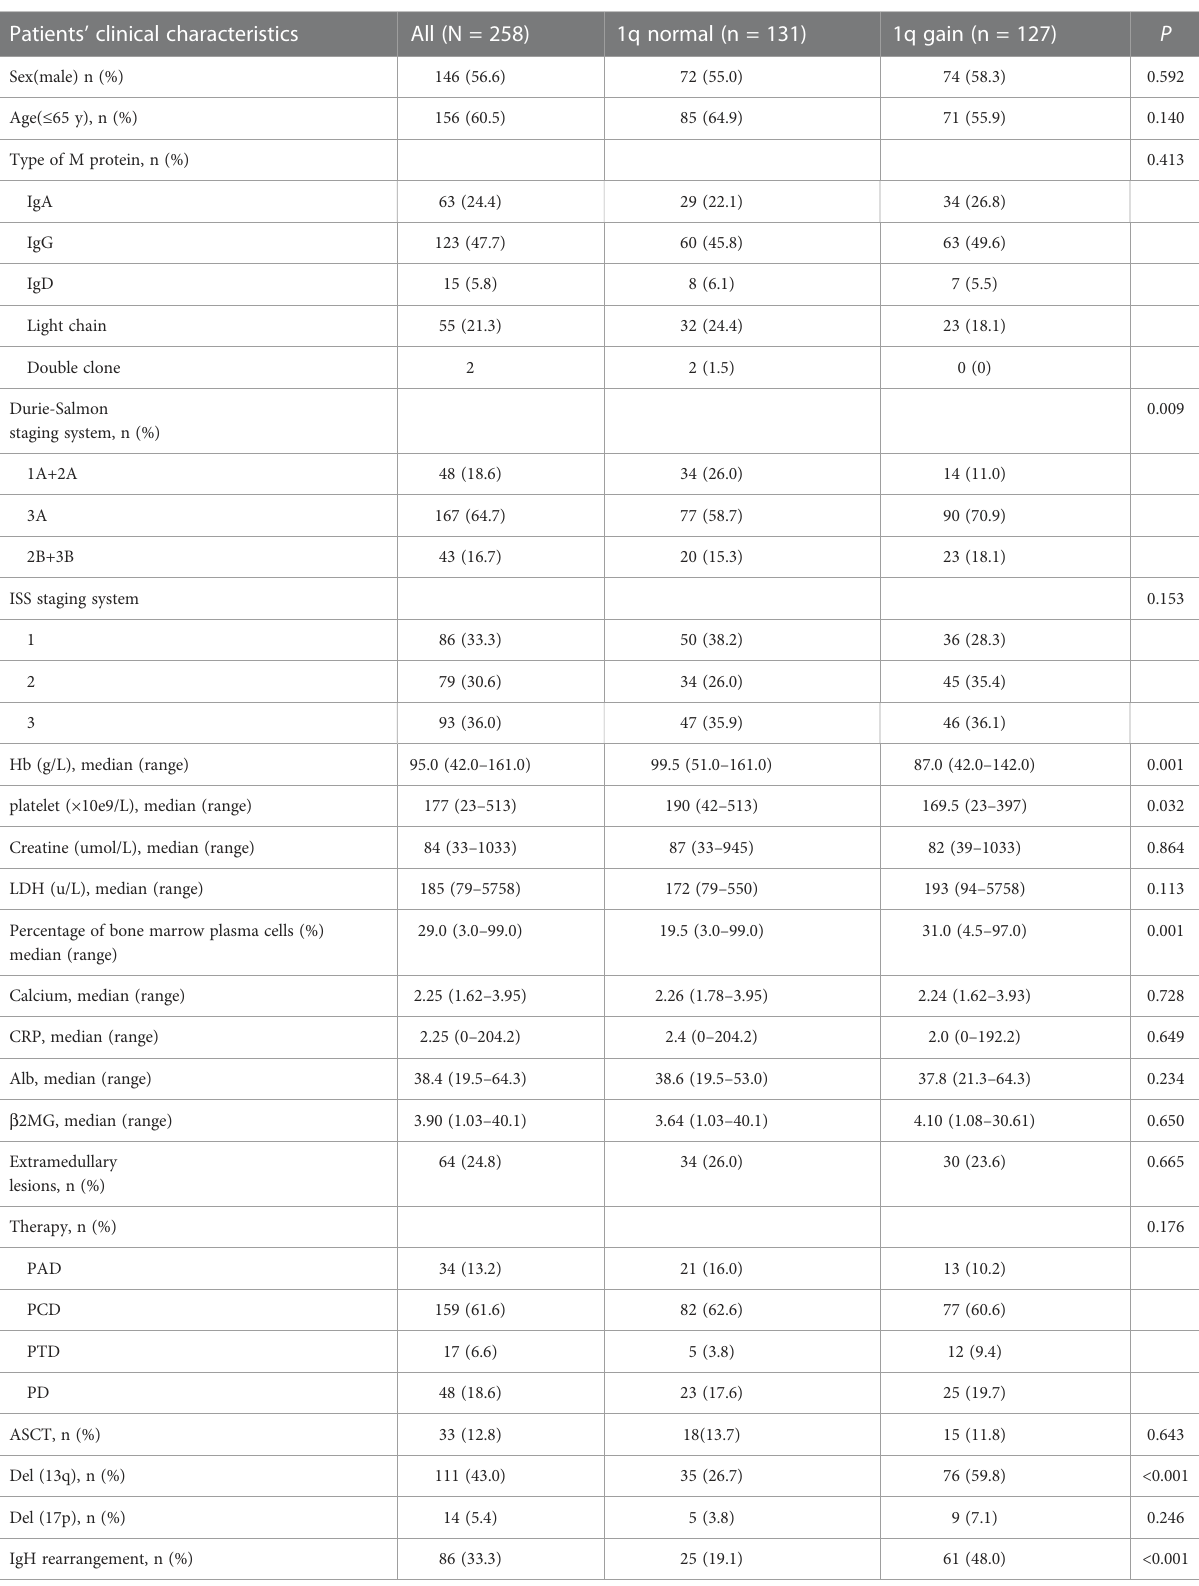
TABLE 2 Baseline clinical characteristics and 1q abnormalities of the patients with multiple